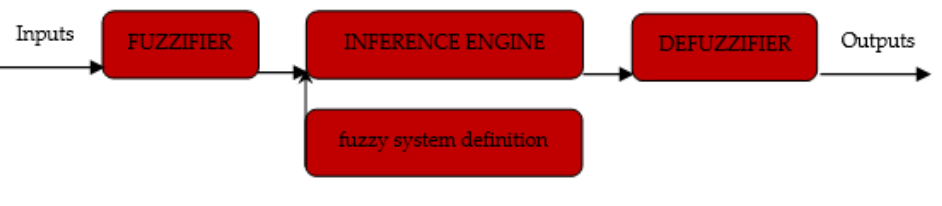
Figure 3. FIS block diagram [80].